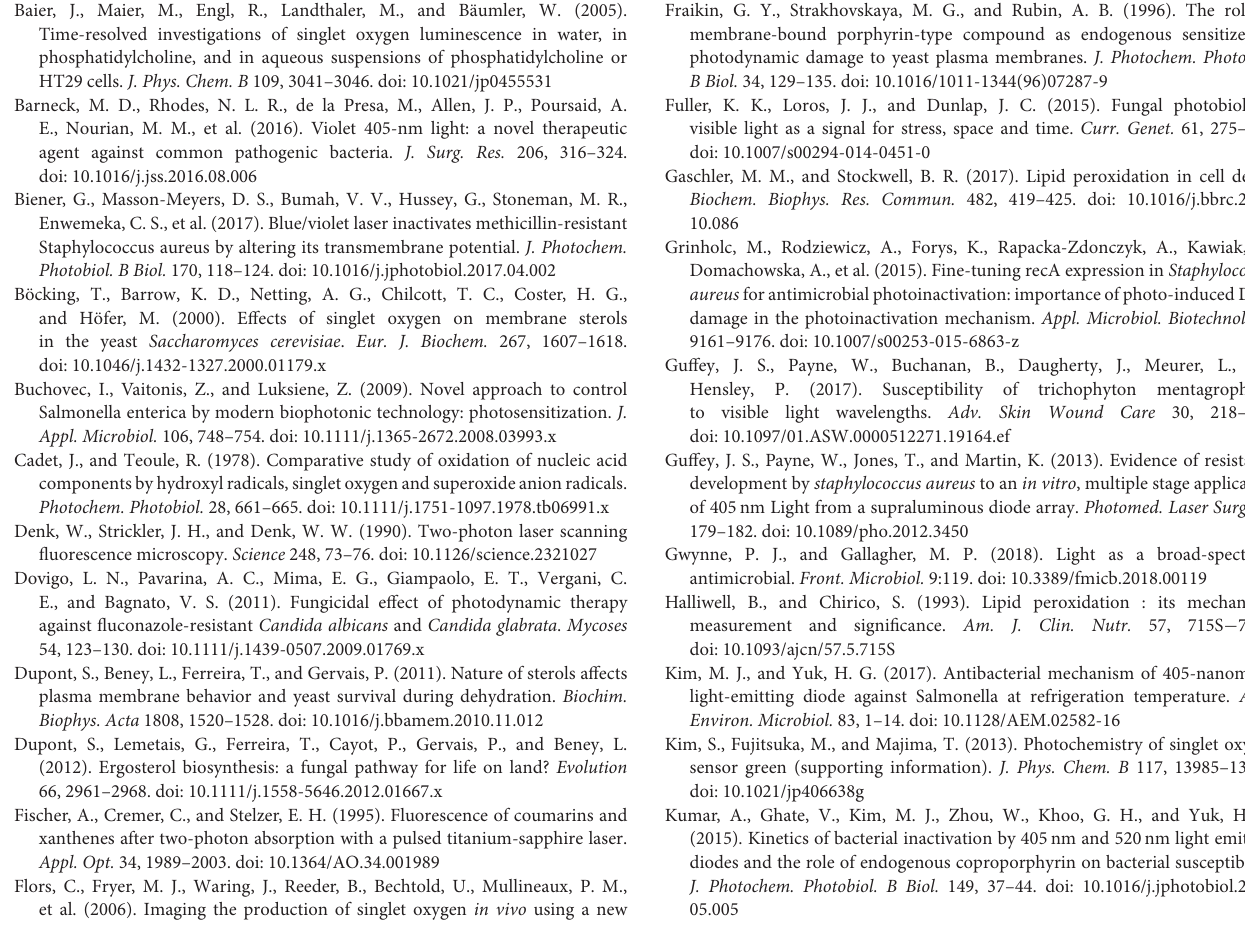
Figure S1 | Cycle with acquisition phase (4s, 400 W/cm 2 ) and excitation phase (2s) at different light powers (1.5.10 4 ; 1.7.10 4 ; 1.9.10 4 ; 2.3.10 4 and 2.6.10 4 W/cm 2 ). Figure S2 | Evolution of fluorescence intensity in two excitation area (Region of interest: ROI) delimited by a red rectangle. The two ROI are exposed to light stimulation phases of 1.5.10 4 W/cm 2 . ROI 1 contains no any yeast cell. ROI 2 contains 1 yeast cell. (A) Photography of the initial photo-oxidation treatment induced by the production of 1 O 2 and labelled by SOSG (6mg/L) in Saccharomyces cerevisiae cells acquired thanks to fluorescence and two-photon microscopy at 830nm for a light power of 400W/cm 2 . (B) Photography after 150s of treatments and (C) photography of the end of the photo-oxidation treatment at t = 300s. (D) Evolution curve of fluorescence intensity in Arbitrary Unity (A.U.) for the two ROI. Figure S3 | Visualization of plasma membrane permeabilization for six cells exposed to a light power of 1.5.10 4 W/cm 2 at 830nm in the plasma membrane area.